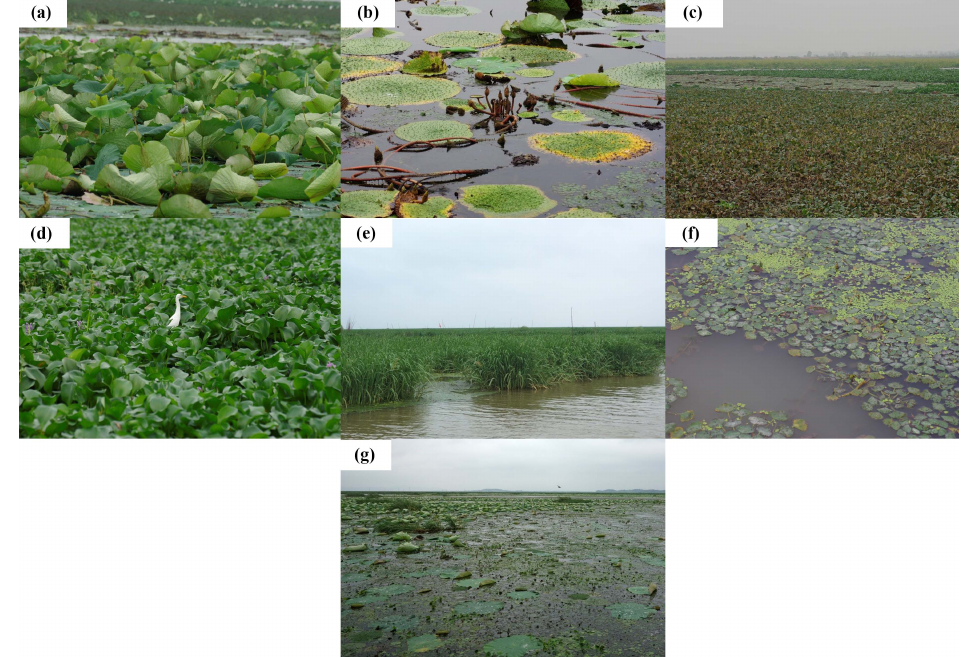
Figure 2. Photographs of aquatic vegetation observed in Longgan Lake. ( a ) Nelumbo nucifera Ass., ( b ) Euryale ferox Ass., ( c ) Trapa bicornis Ass., ( d ) Eichhornia crassipes Ass., ( e ) Zizania caduciflora + Polygonum orientale Ass., ( f ) Trapa litwinowii + Eichhornia crassipes + Spirodela polyrhiza Ass. and ( g ) Nelumbo nucifera + Trapa litwinowii + Euryale ferox